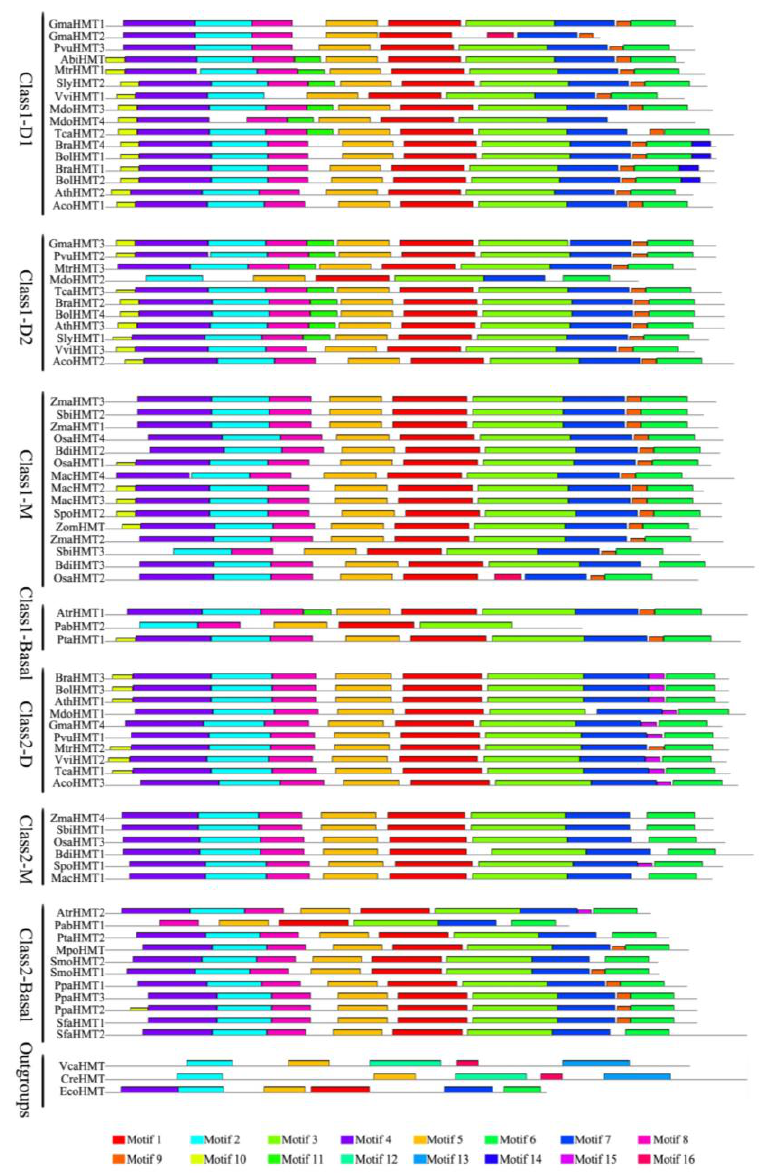
Figure 2. Conserved motifs of HMT proteins identified on the MEME analysis across plants. Each motif is represented by a colored box numbered on the bottom . The amino acid sequences of these motifs are presented in Figure S1 in Additional file 3. The black lines represent unique sequences. The scale bar indicates number of amino acids. Names to the left indicate the clades to which the sequences belong to according to Figure 1.